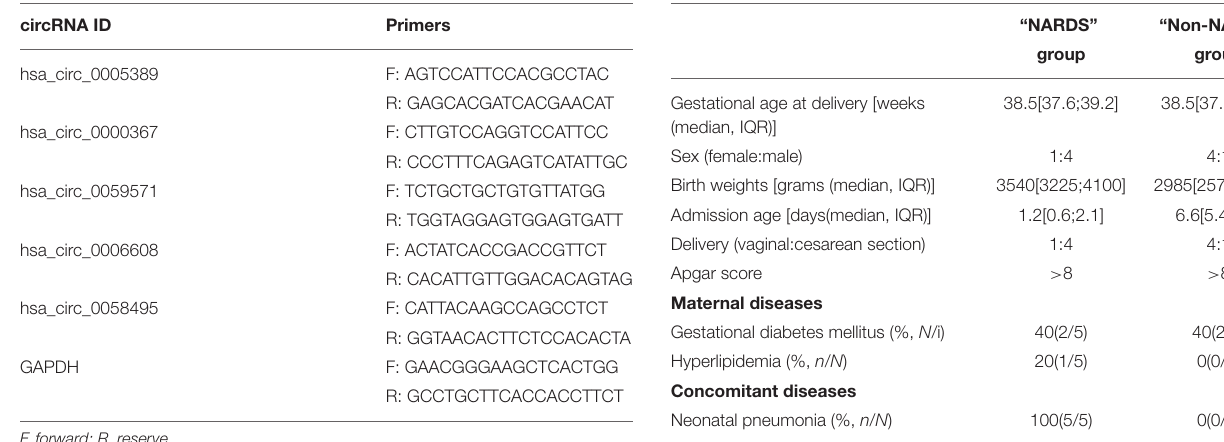
TABLE 2 | Clinical characteristics of 10 patients in the present